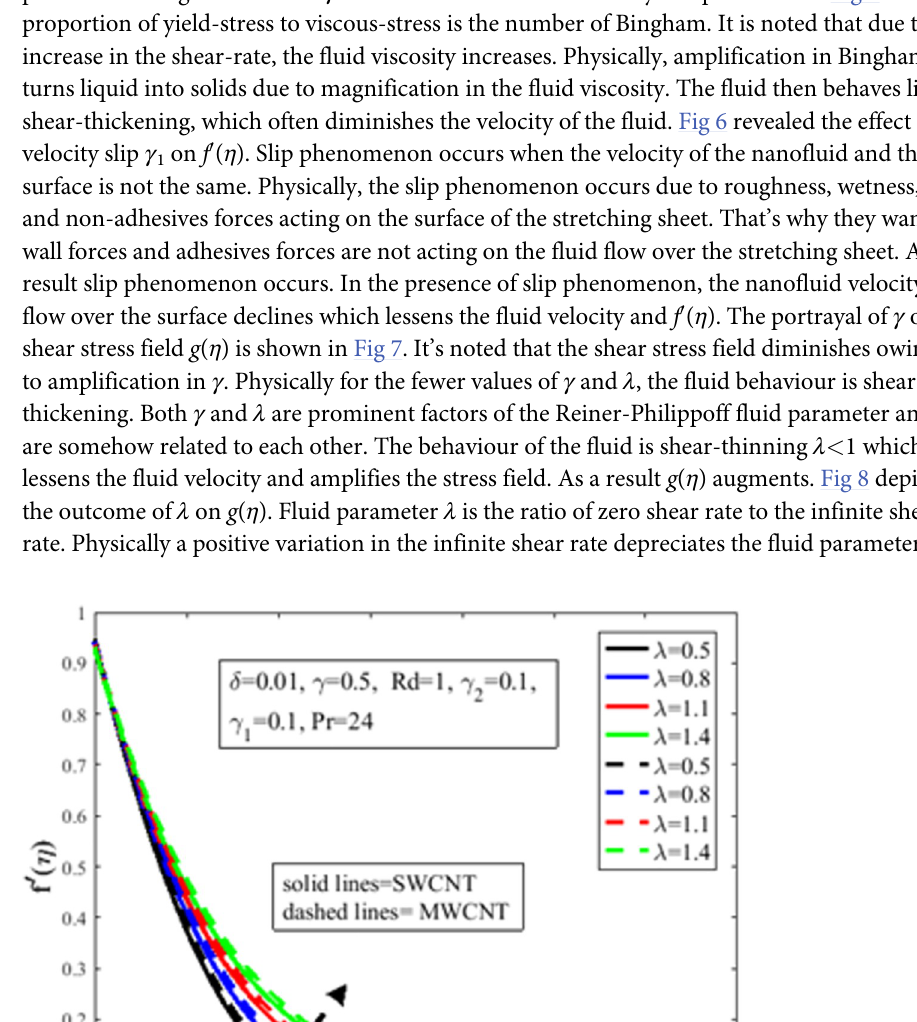
Fig 4. Effect of λ on f 0 ( η